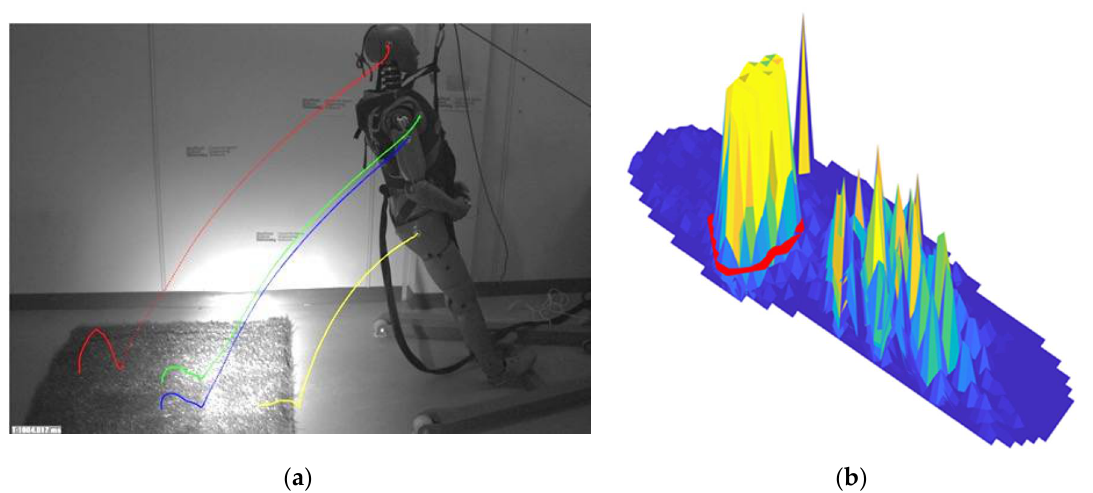
Figure 3. ( a ) Illustration of ATD fall (e.g., marker trajectory) onto 3G turf; ( b ) automatic, regional pressure sensor analysis (red ring highlighting mock-EPTS device region) used to quantify